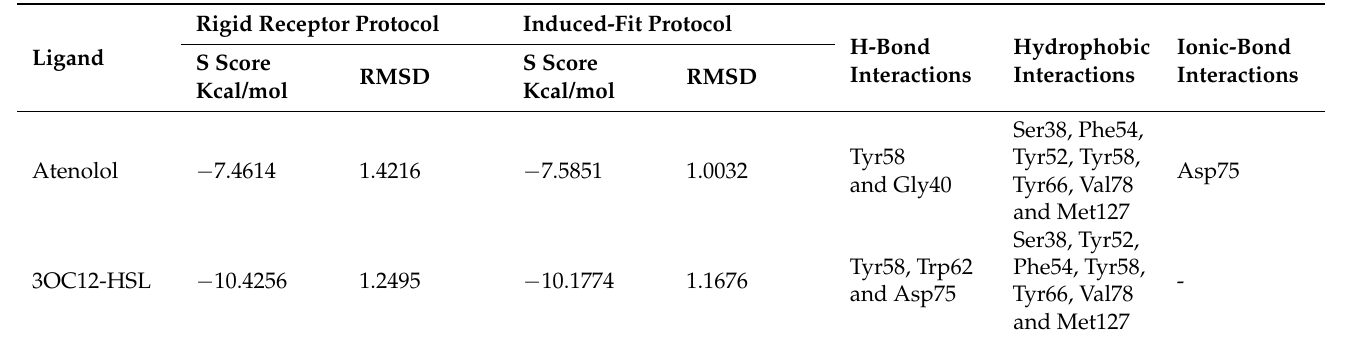
Table 1. Docking results for both 3OC12-HSL and atenolol with P. aeruginosa quorum-sensing control repressor.